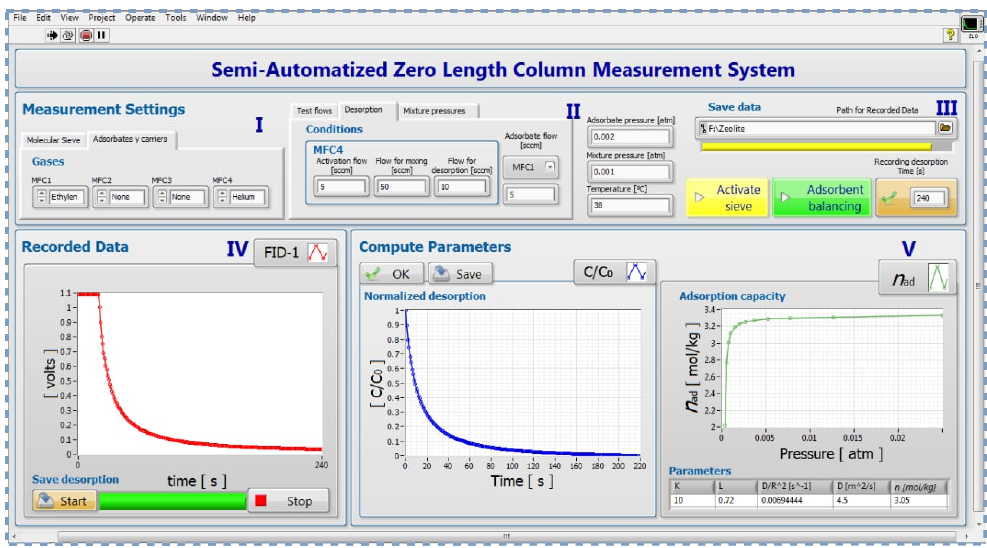
Figure 3. Labview GUI of semi-automatic experiment